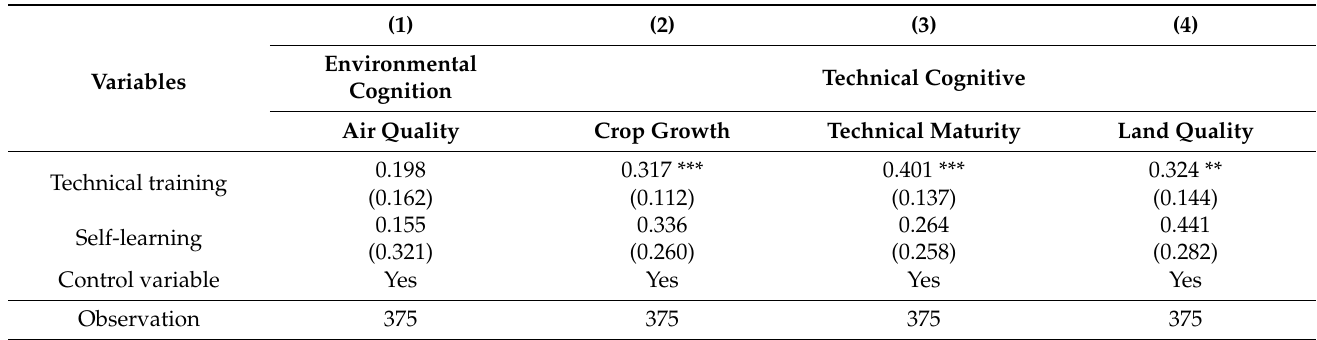
Table 7. Mechanism analysis of technical training affecting farmers’ adoption